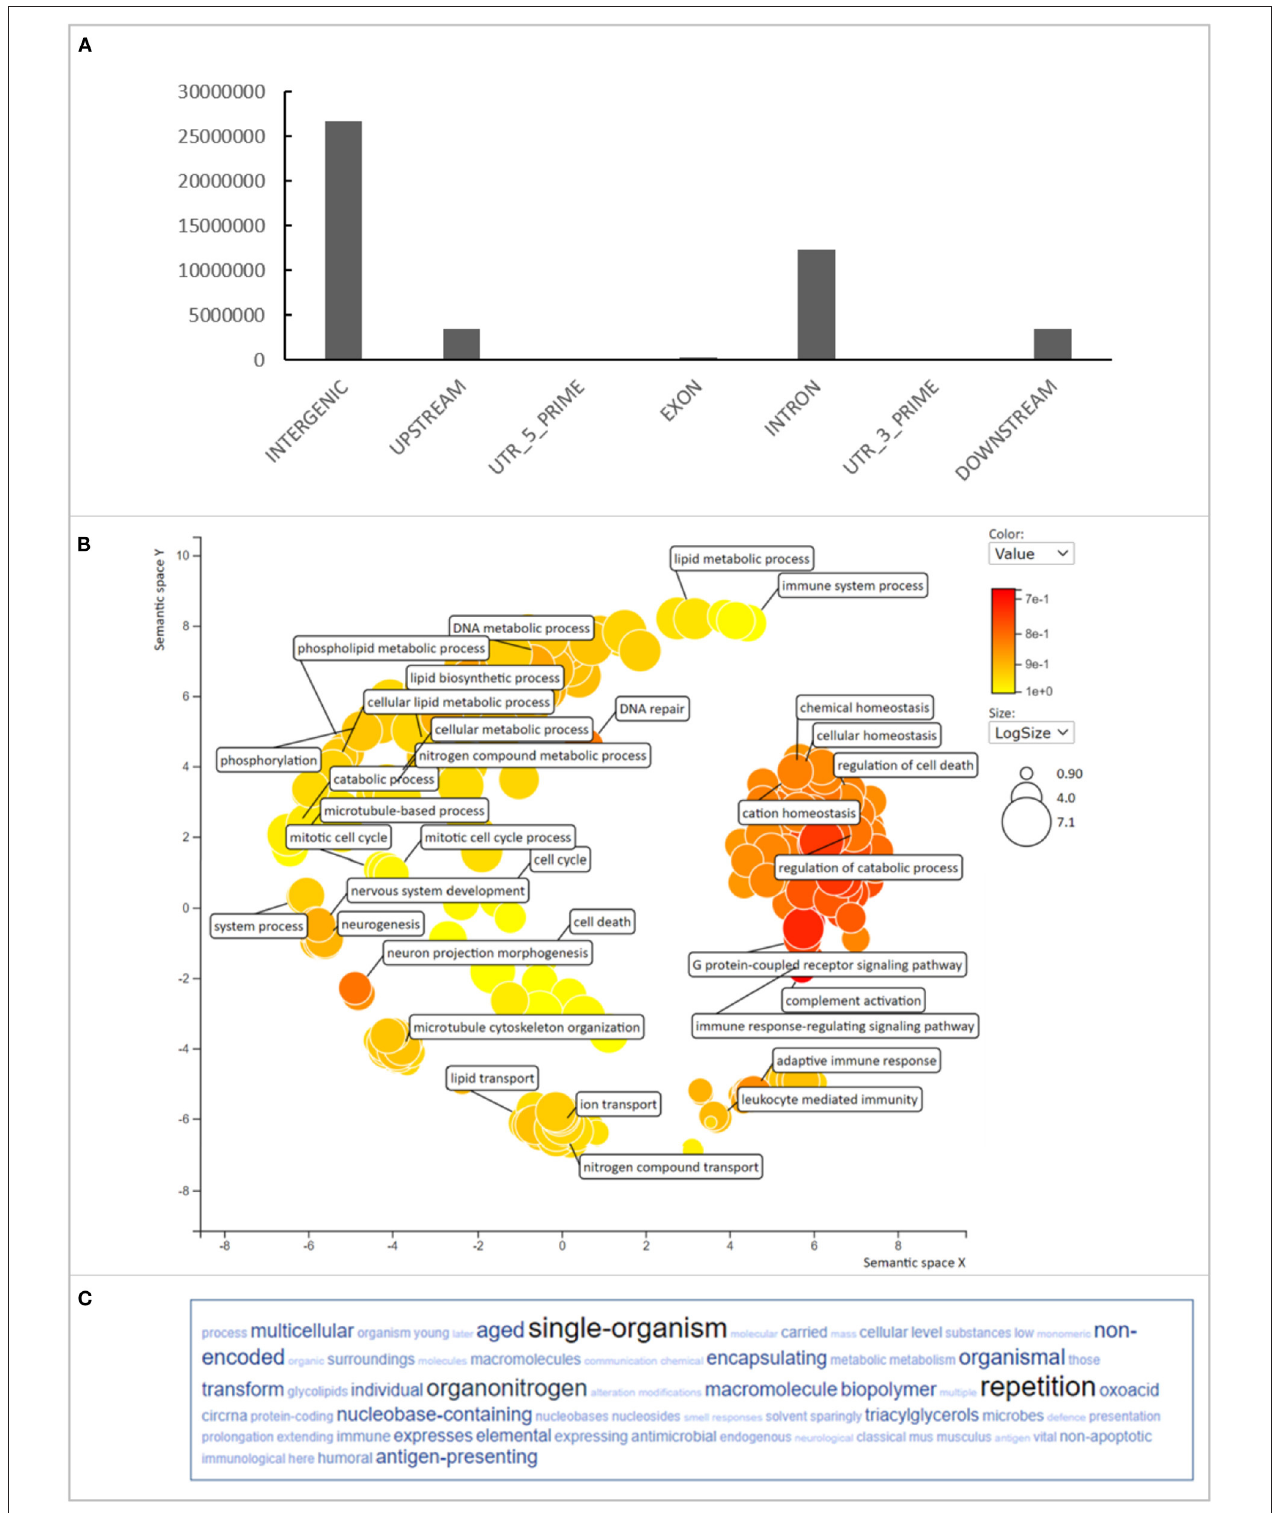
FIGURE 1 | Variant annotation in Degu genomes. (A) Represents the variant distribution through the different genomic regions. (B) Represents the GO term enrichment of genes that had missense variants found in different Degu genomes. (C) Represents the most frequent keywords within the GO terms.